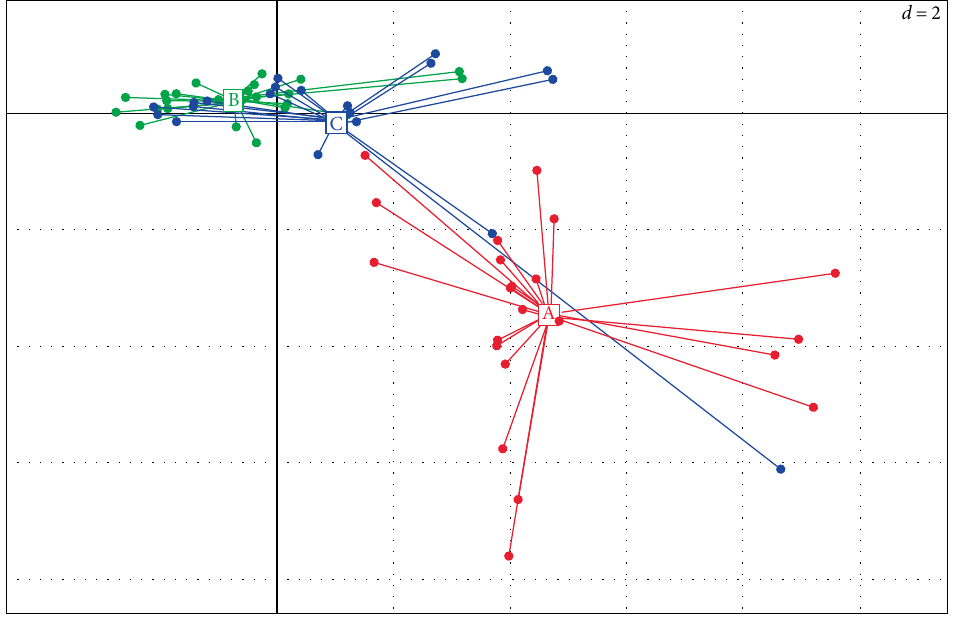
Figure 6: RLQ diagram as defined by the first two axes with projection of the faunal assemblages. The 𝑑 value in the upper right corner is the scale of the graph given by a